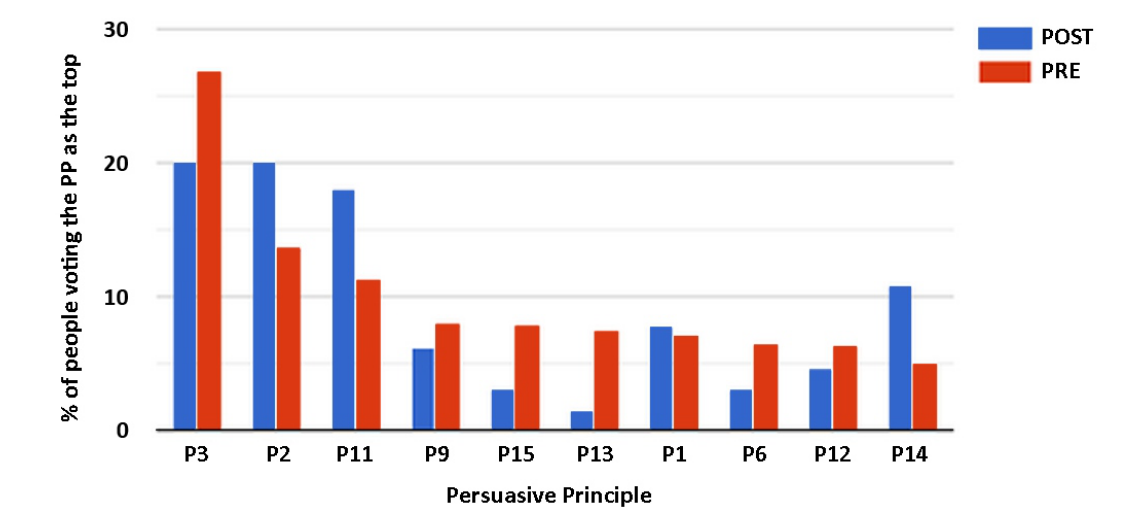
Figure 3. PRE vs. POST-pilot: Ranking of the top ten dominant persuasion principles as voted by the end-users as a top principle.